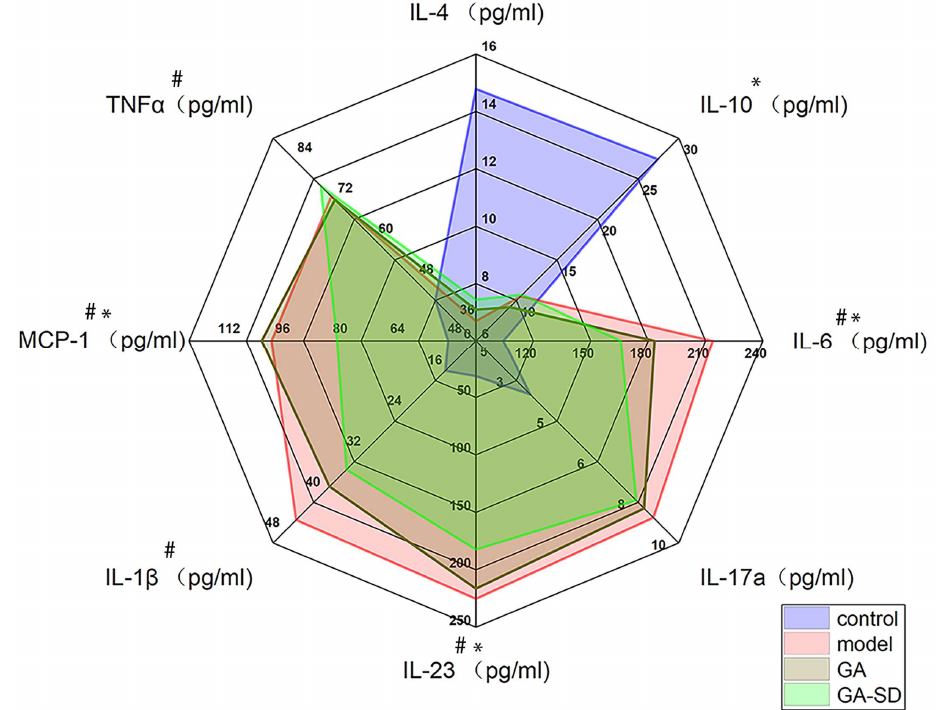
Figure 7. Effect of GA and GA-SD on LPS-induced secretion levels of cytokines such as IL-4, IL-1β, IL-6, MCP-1, TNF-α, IL-23, IL-17A, and IL-10 in RAW264.7 cells. Values are presented as the mean ± SD ( n = 3). # p < 0.05 vs. model group. * p < 0.05 vs. LPS group.